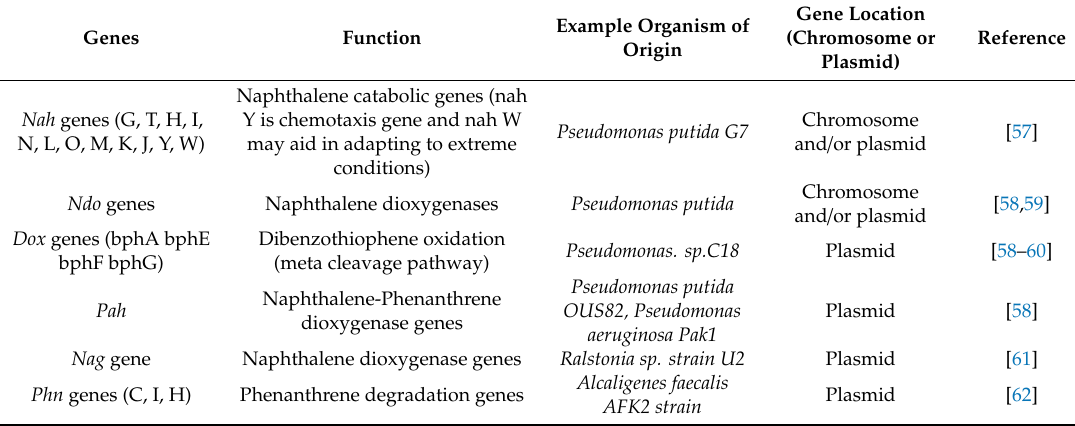
Table 1. Microbial genes implicated in hydrocarbon degradation with their function / pathway and representative host